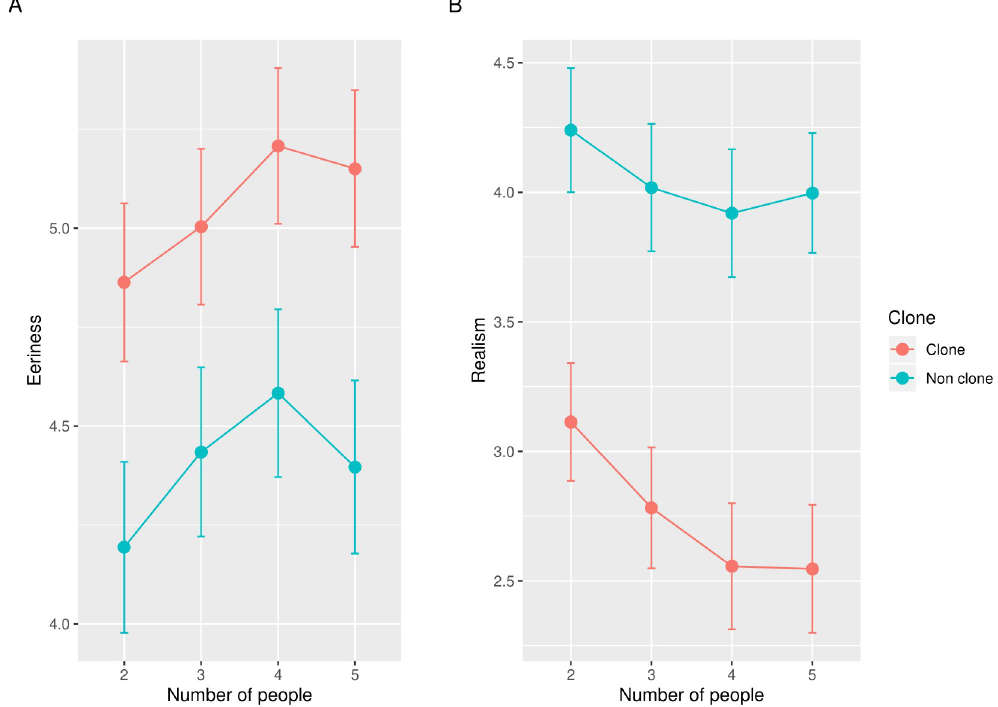
Fig 3. The results of the eeriness and realism evaluation in Study 2. Error bars indicate the standard errors of the mean. The vertical axes indicate the mean eeriness (A), the realism scores (B) for images in each condition. The lower scores in realism indicate more improbable